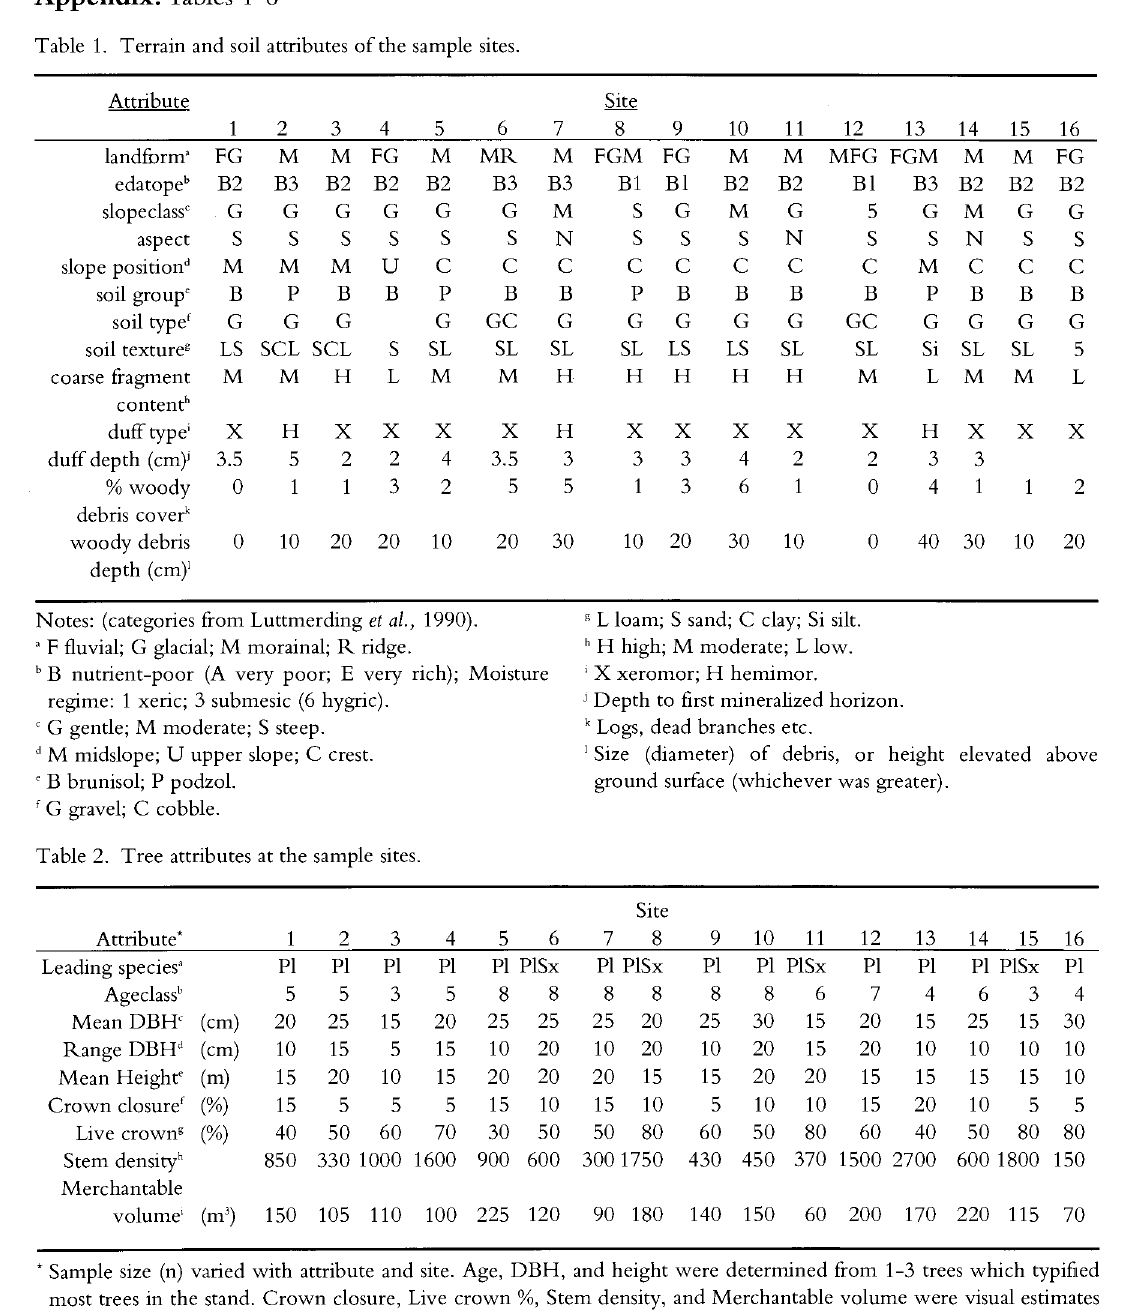
Table 1. Terrain and soil attributes of the sample sites.